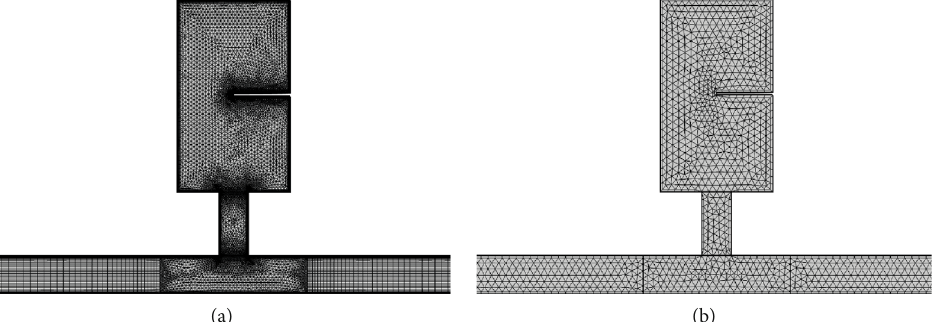
Figure 2: Computational unstructured mesh of the 2D-modelled duct with the modi fi ed Helmholtz resonator attached and a rigid ba ffl e implemented: (a) 1,260,360 cells and (b) 63,920 cells.